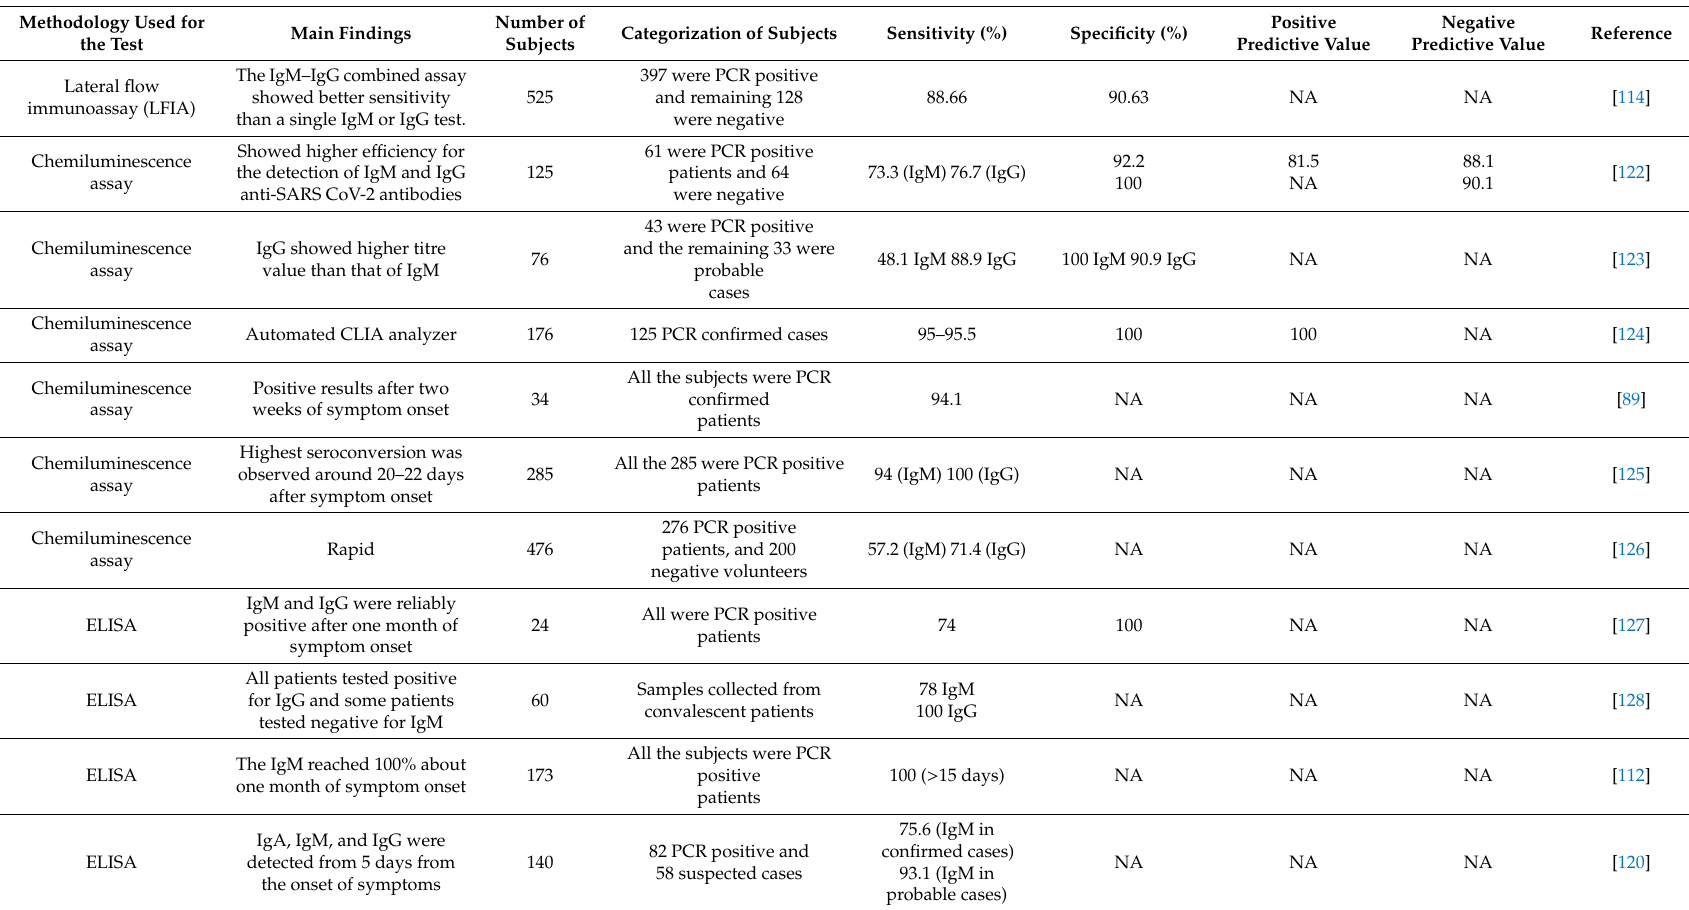
Table 1. Various antibody-based COVID-19 tests, their features, and available validation